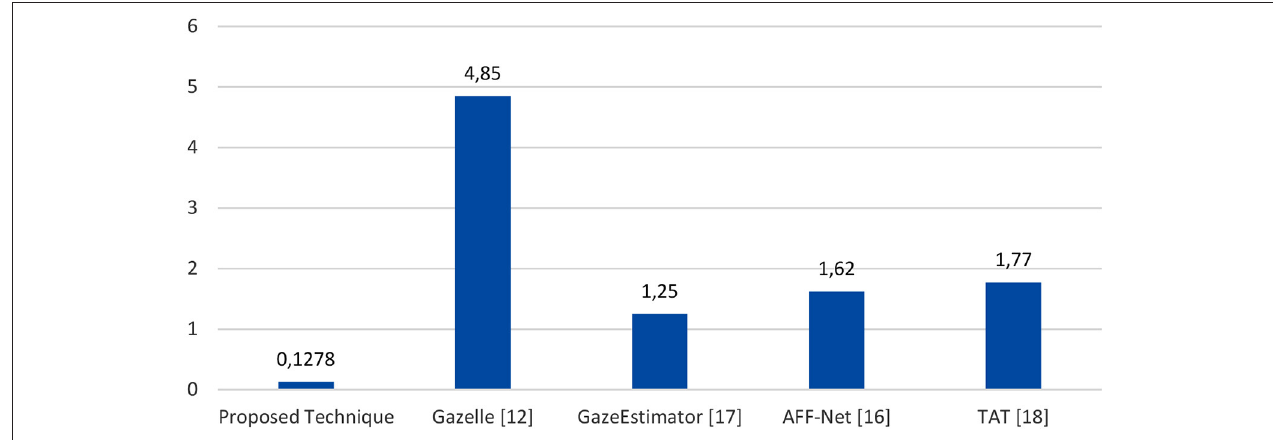
FIGURE 13 | Comparison between proposed technique and four